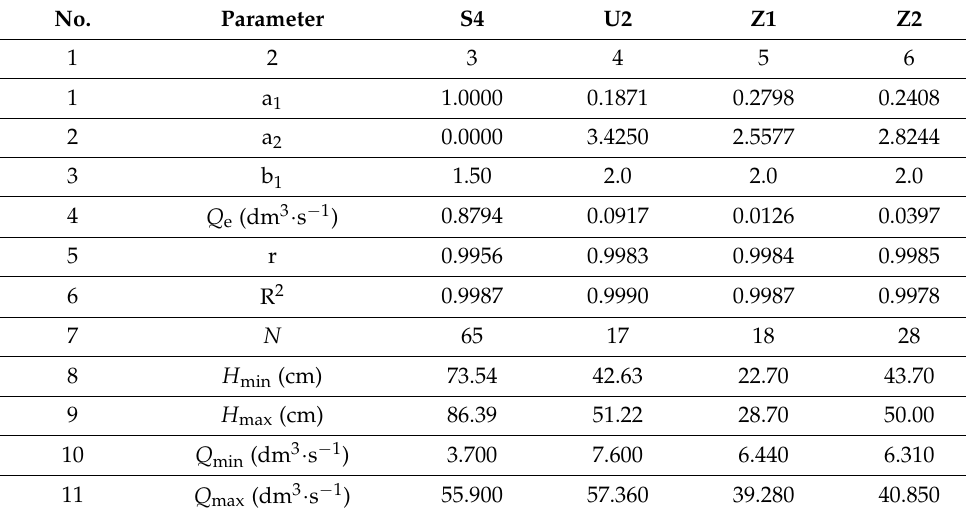
Figure 8. Discharge curves of beam regulators at different heights of the overflow edge position: 1—variant S4; 2—variant U2; 3—variant Z1; 4—variant Z2. Table 2. Parameters of Equation (4) of regulation Q r discharge